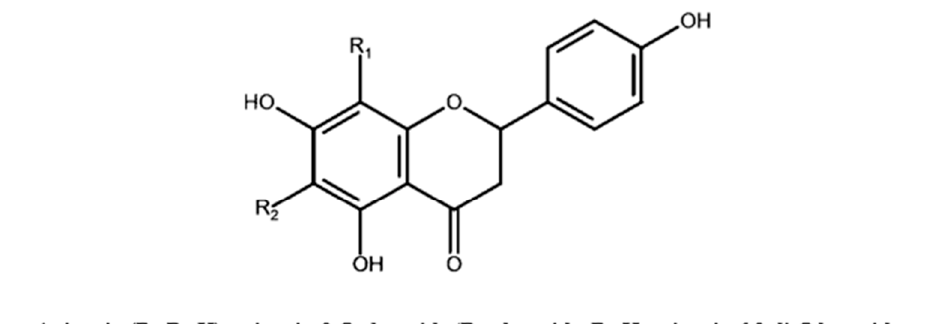
Figure 3. Chemical structure of apigenin and its glycosides detected in laurel leaves (adapted from [13]) .